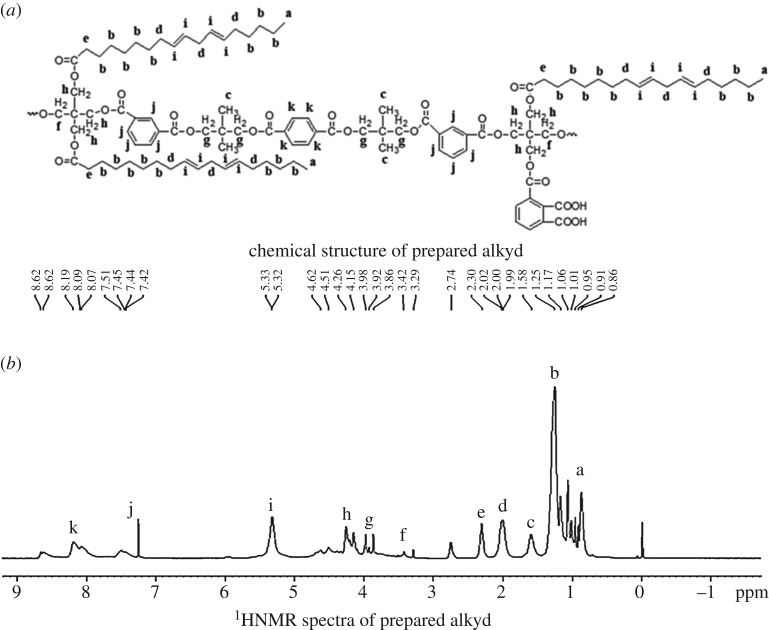
Chemical structure (a) and 1HNMR spectra (b) of prepared alkyd.